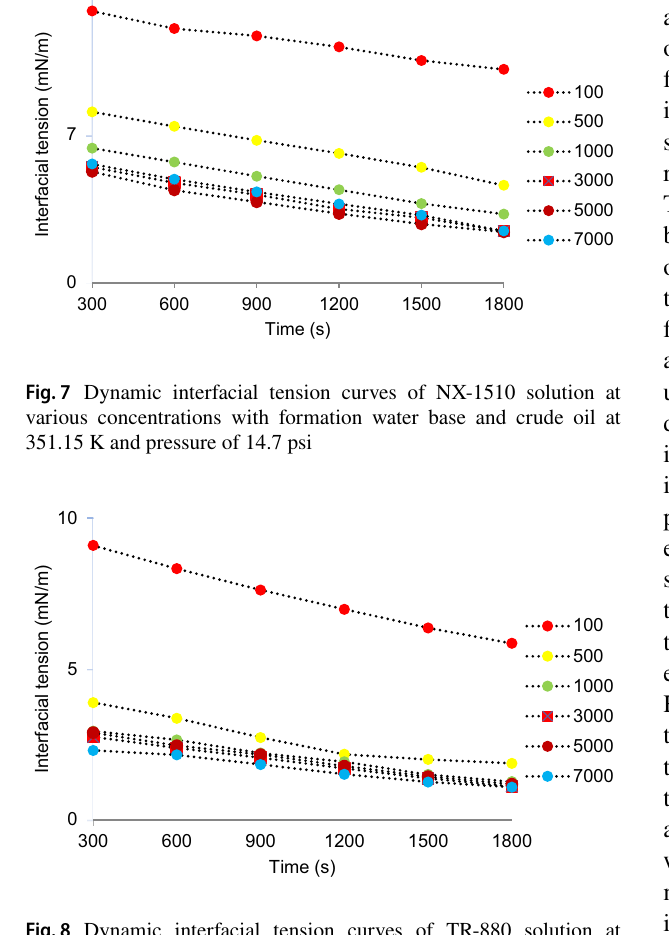
Fig. 8 Dynamic interfacial tension curves of TR-880 solution at various concentrations with formation water base and crude oil at 351.15 K and pressure of 14.7 psi